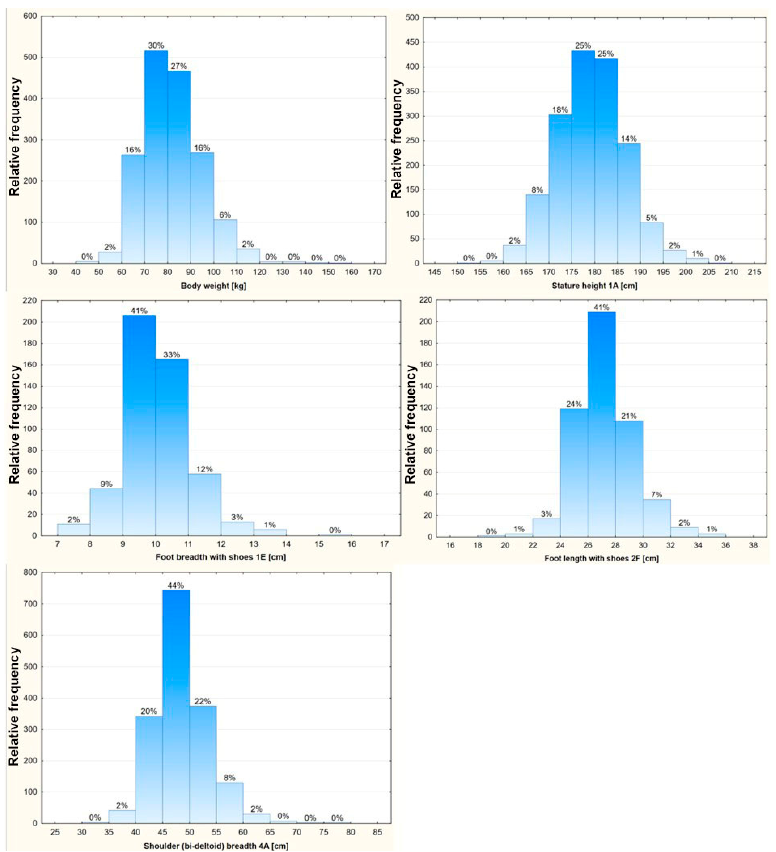
Figure 3. Histograms of analyzed selected anthropometric dimensions.